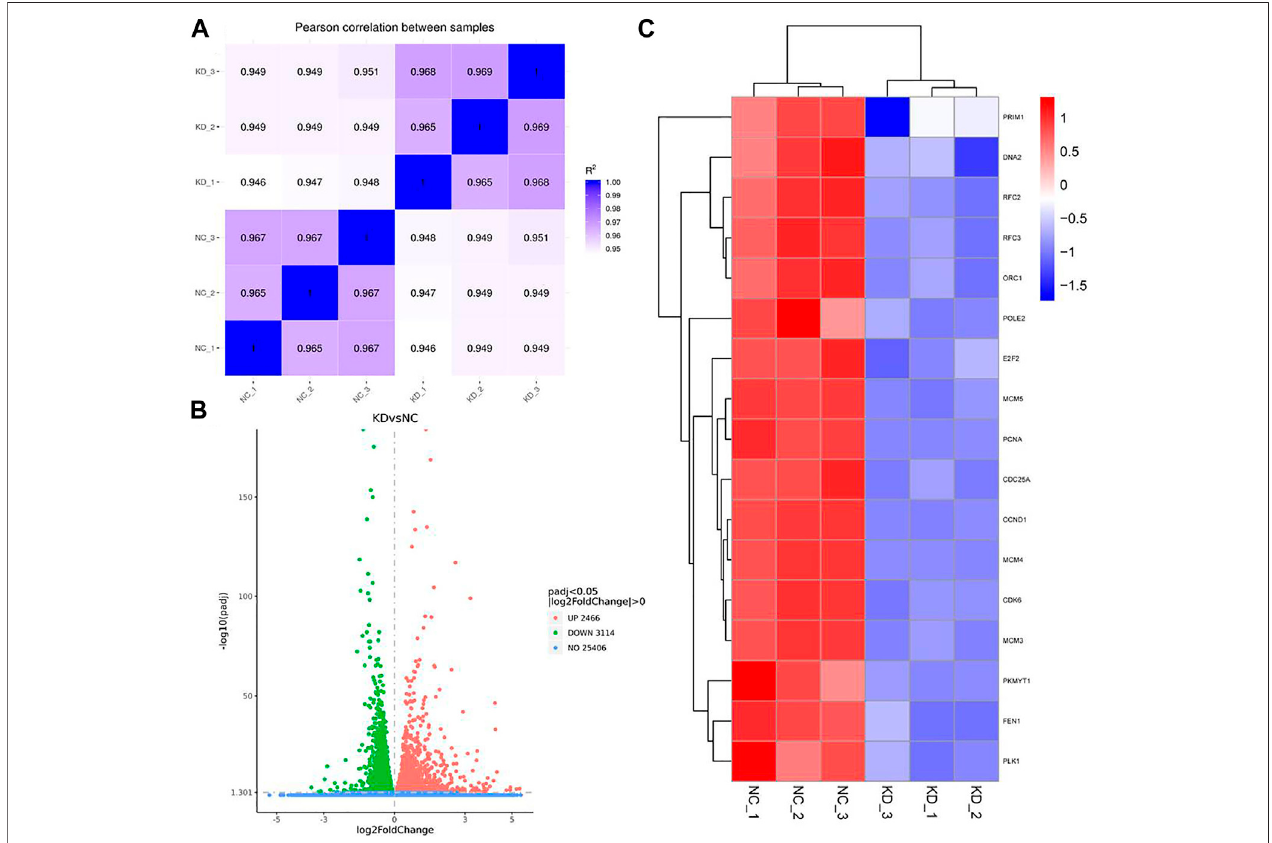
FIGURE 2 | Heatmap showing the expression of genes in the lung cancer cell line A549 according to single-cell RNA sequencing. Cells are grouped by HuR KD status. (A) . Pearson correlation between HuR KD A549 cells and the control group. (B) . HuR KD A549 cells were analyzed by RNA sequencing, which revealed 2,466 upregulated genes and 3,114 downregulated genes. (C) The gene heatmap shows the expression of major genes involved in the cell cycle between the two